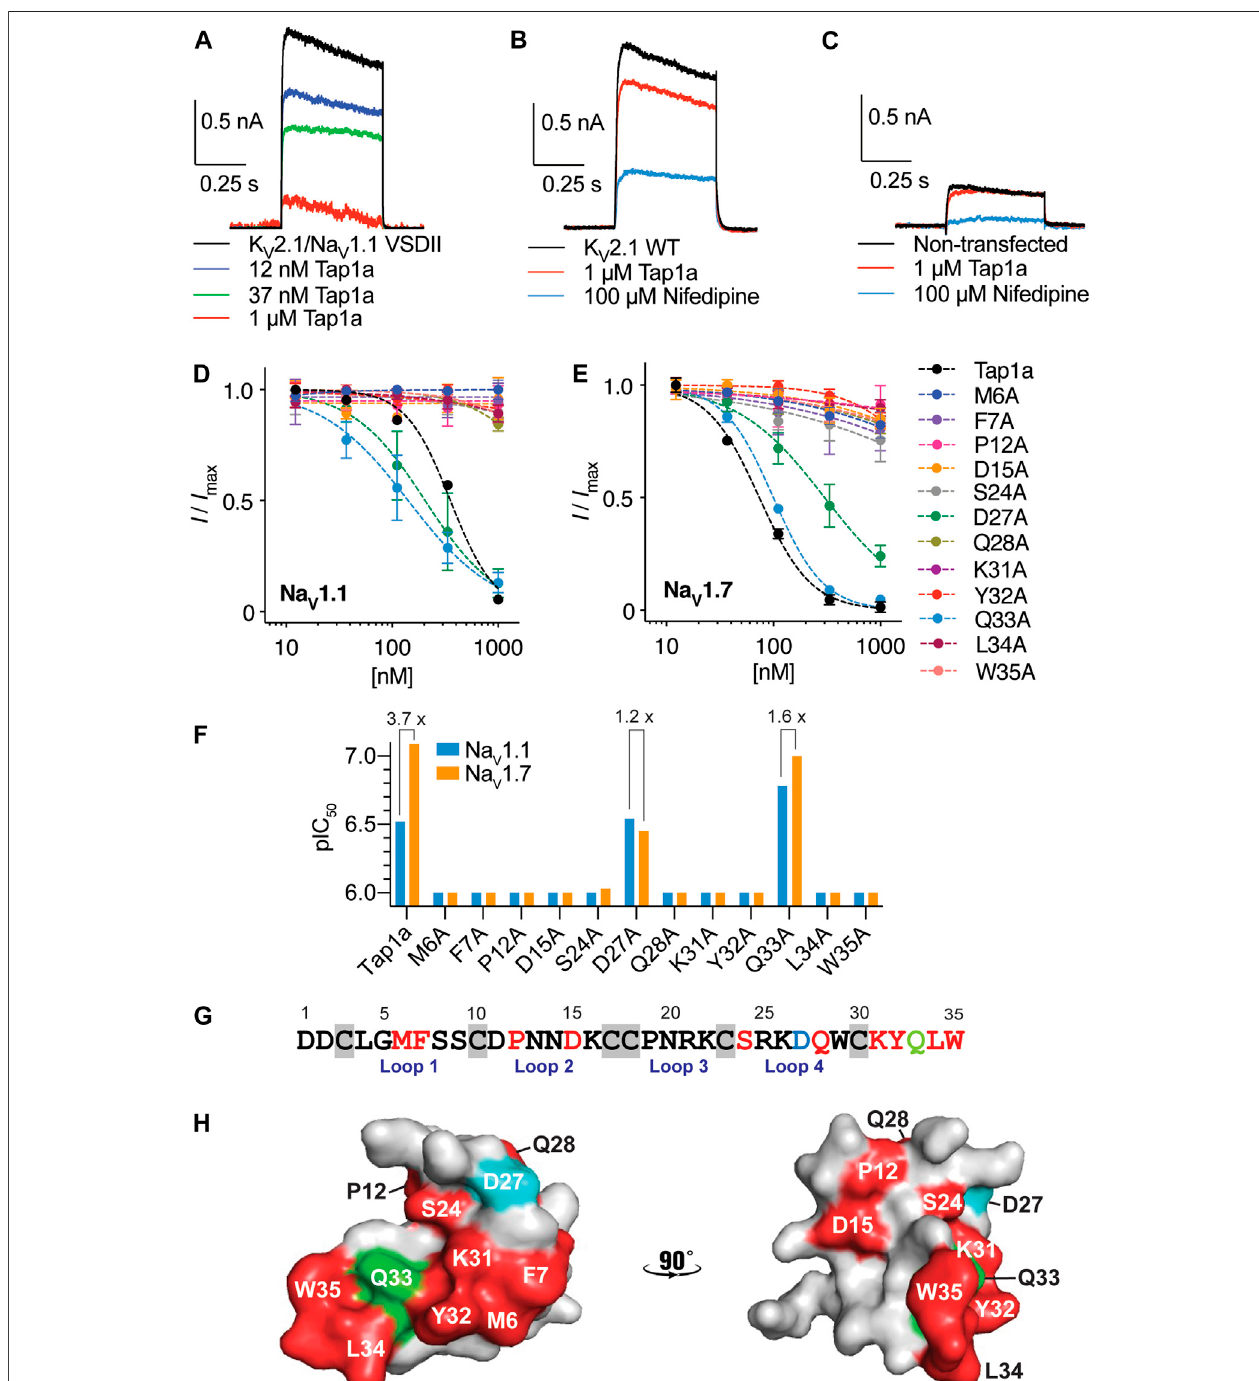
FIGURE 1 | Binding site of Tap1a at hNa V 1.1 and pharmacological properties of Tap1a alanine mutants for hNa V 1.1 and hNa V 1.7 channels. (A – C) A rK V 2.1/ hNa V 1.1 chimera containing the paddles S3 – S4 from DII from Na V 1.1 was used to explore the binding site of Tap1a over Na V 1.1. Potassium currents were elicited by a pulse at +20 mV for 500 ms from – 90 mV holding potential. (A) The K + currents are shown before and after addition of increasing concentrations of Tap1a. (B) Tap1a had weak effect on wild type rK V 2.1 at 1 μ M. (C) Tap1a had no effect on endogenous K + currents from non-transfected HEK293 cells. Data are representatives from n (cid:1) 3 – 5 independent experiments for each condition assayed, one whole cell was considered per independent experiment. (D, E) Tap1a and alanine mutants produced byrecombinant expression were characterized via automated electrophysiology using QPatch 16X and HEK293 cells expressinghNa V 1.1 (D) or hNa V 1.7 (E) co-expressed with the β 1 subunit. Sodium currents were elicited by depolarization to 0 mV for 20 ms from a pre-pulse at – 120 mV for 200 ms and – 80 mV holding potential.Serialdilutedconcentrationsofeachalaninemutantwereincubatedwiththecellsfor5 minatholdingpotentialbeforechannelactivation.Dataaredescribedby